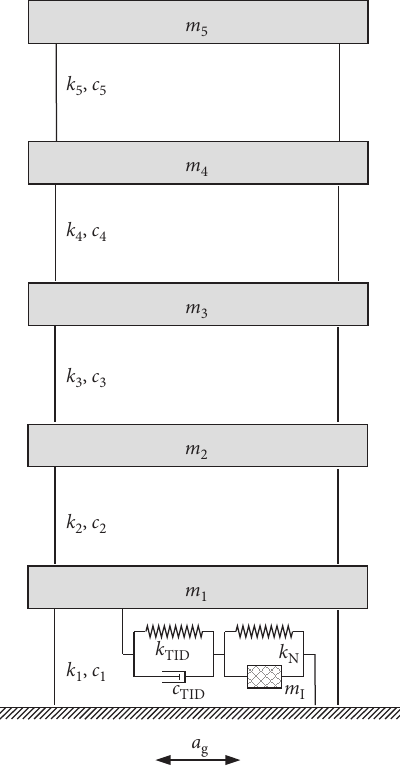
Figure 7: Mechanical model of the 5-storey frame building with TID_NSD system installed at the ground floor. Table 4: Structural parameters of the case study